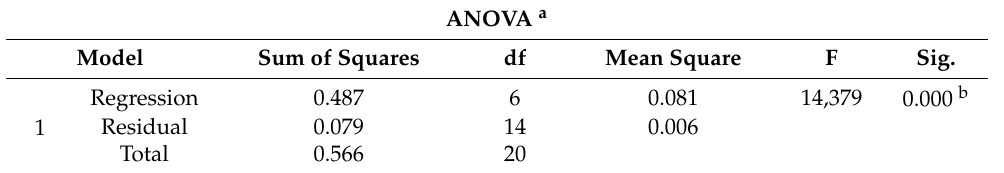
Table 4. ANOVA method for Bulgaria.